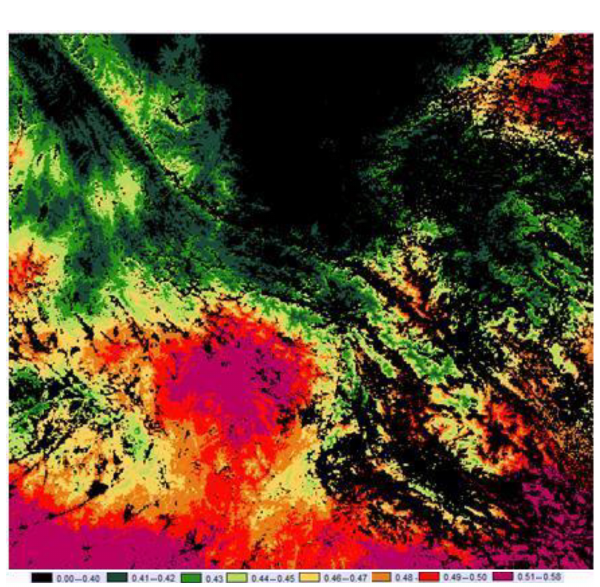
Figure 4. Potential map for transition from forest to croplands.